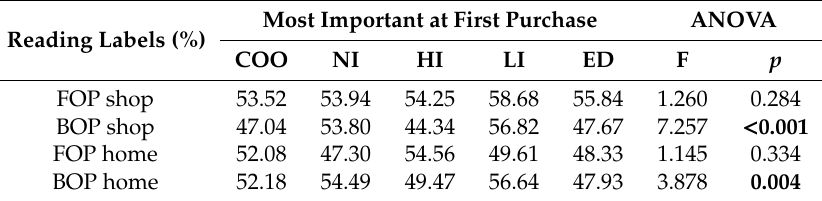
Table 13. Reading food labels by the most important information on the food label at the first purchase (excluding price).